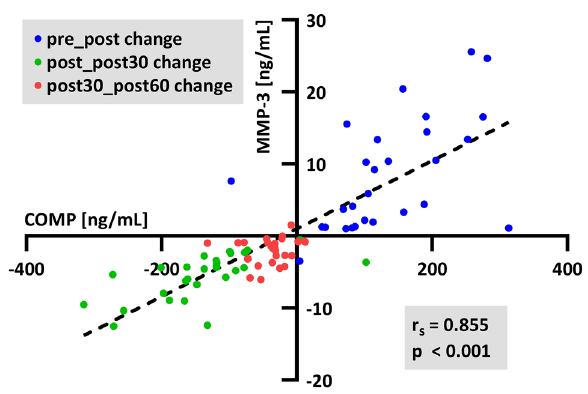
Figure 4. Spearman correlation of absolute concentration changes of subsequent sampling time points between COMP and MMP-3.